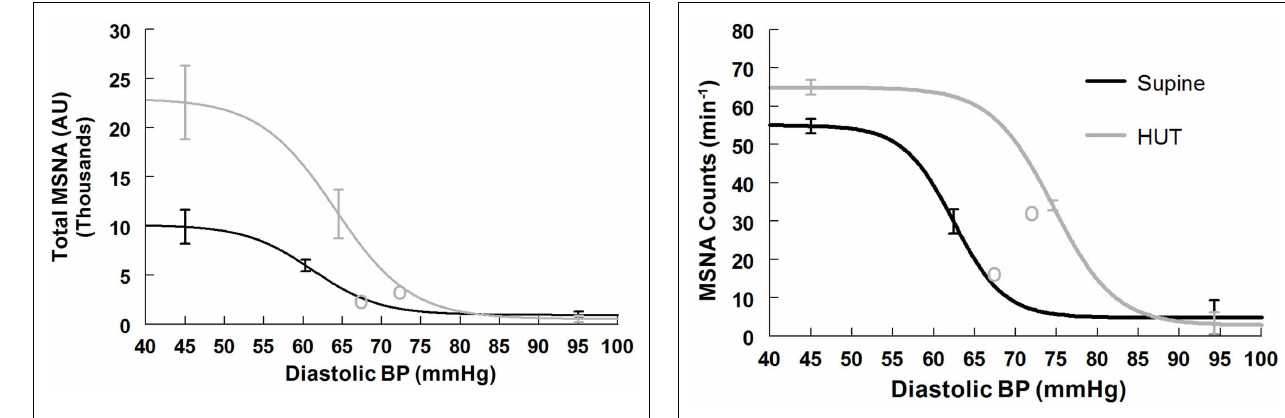
FIGURE 5 | Supine and upright total MSNA response relationships obtained by averaging data-fits over all subjects during the Oxford maneuver. The upright curve is shifted from supine but the maximum slope (sensitivity), response range, and saturation are also increased when upright.